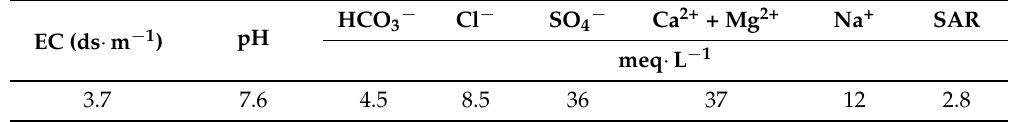
Table 2. Chemical properties for irrigation water of experiment.